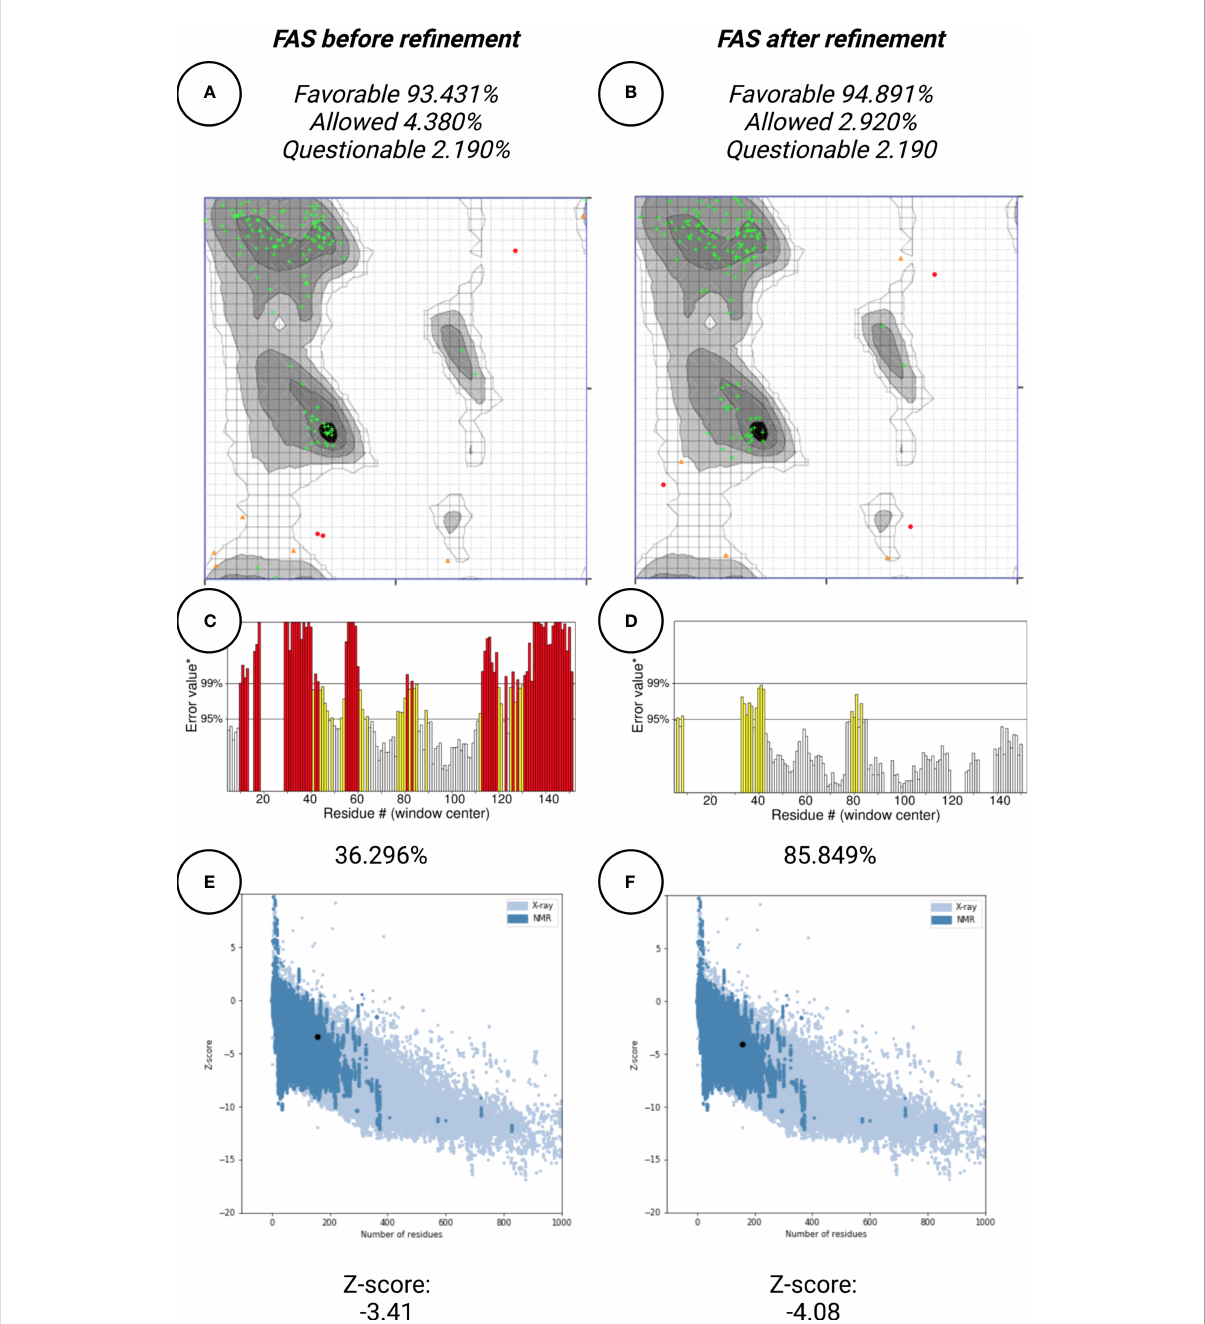
FIGURE 7 Protein quality veri fi cation for Fas tertiary structure. In this illustration, the proteins (Fas/FasL) are evaluated based on structural Bioinformatics rules. After re fi nement, Fas structures was favorable. (A, B) In the Ramachandran plot, more residues are located in favorable regions. (C, D) ERRAT score was improved from 36.296% to 85.849%. A score over 80% shows the re fi ned structure has good quality. (E, F) ProSA Z-score was improved from -3.41 to -4.08 which is within the acceptable range for structures with the same aminoacid